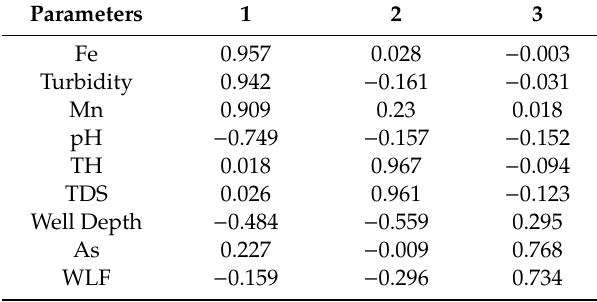
Table 5. Varimax rotated R-mode factor loading matrix for groundwater of the river valley.